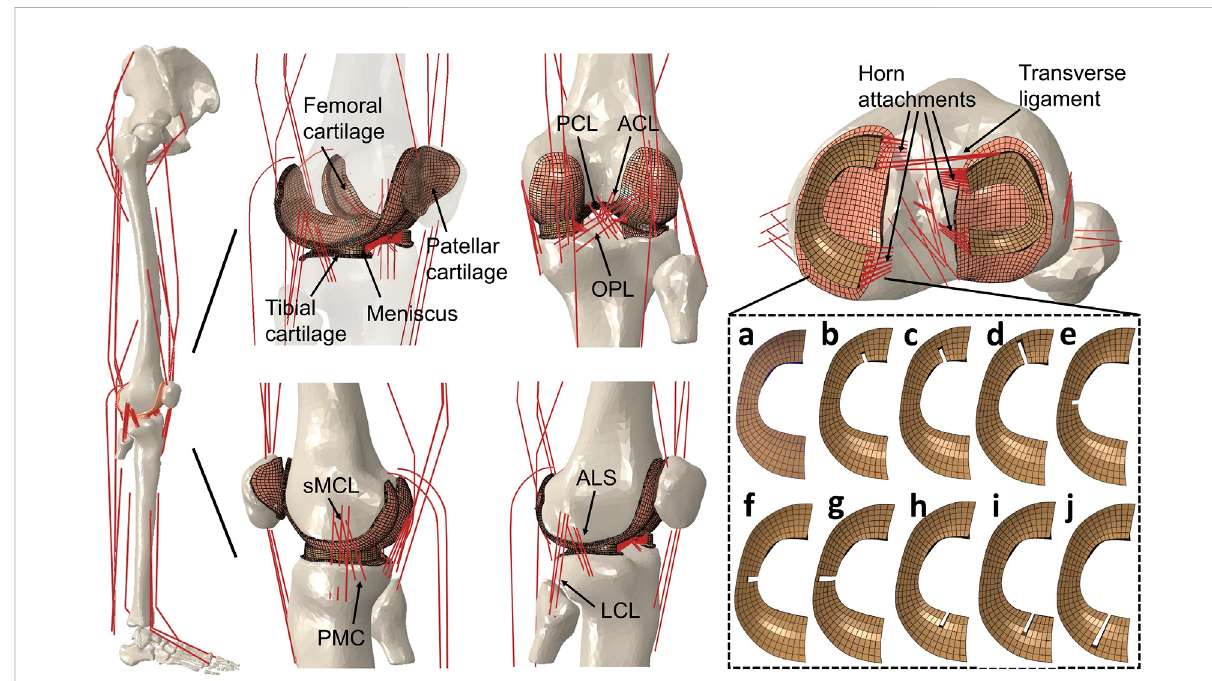
FIGURE 1 Right lower limb fi nite element musculoskeletal models containing knees with an intact healthy meniscus (A) ; a medial meniscus with radial tears in the anterior horn involving three grades with widths of (B) 33%, (C) 50%, and (D) 83%; midbody with widths of (E) 33%, (F) 50%, and (G) 83%; and posterior horns with widths of (H) 33%, (I) 50%, and (J) 83%. A model without medial meniscus, equivalent to total meniscectomy, was also prepared (not shown). The lower limb fi nite element musculoskeletal model includes a 12-DOF knee joint, along with 20 muscles, ligaments (ACL, anterior cruciate ligament; PCL, posterior cruciate ligament; MCL, medial collateral ligament; PMC, posteromedial capsule; LCL, lateral collateral ligament; ALS, anterolateral structure; OPL, oblique popliteal ligament; transverse ligament), cartilage, the meniscus, and meniscus horn